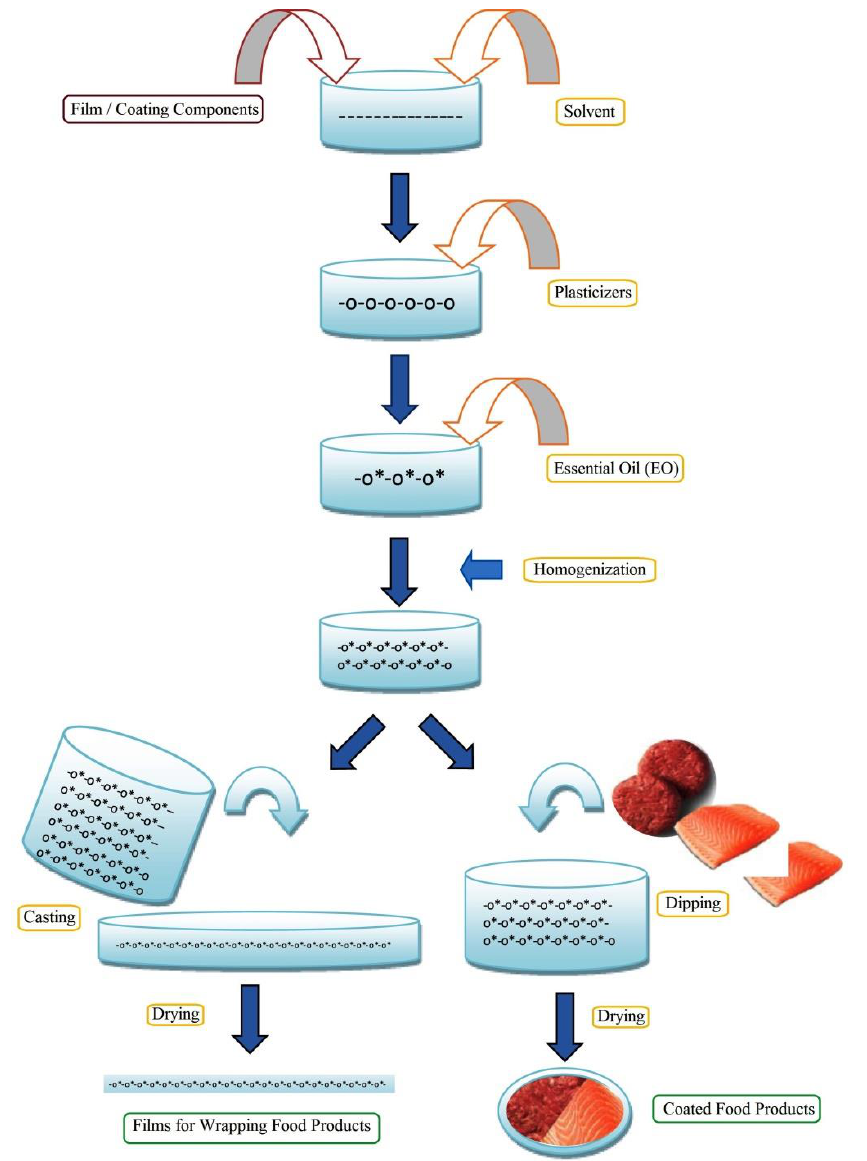
Figure 14. Preparation of polysaccharide-based edible film with tailored properties for food preservation. Reproduced with minor modification from [60]. (Copyright 2020 Elsevier).